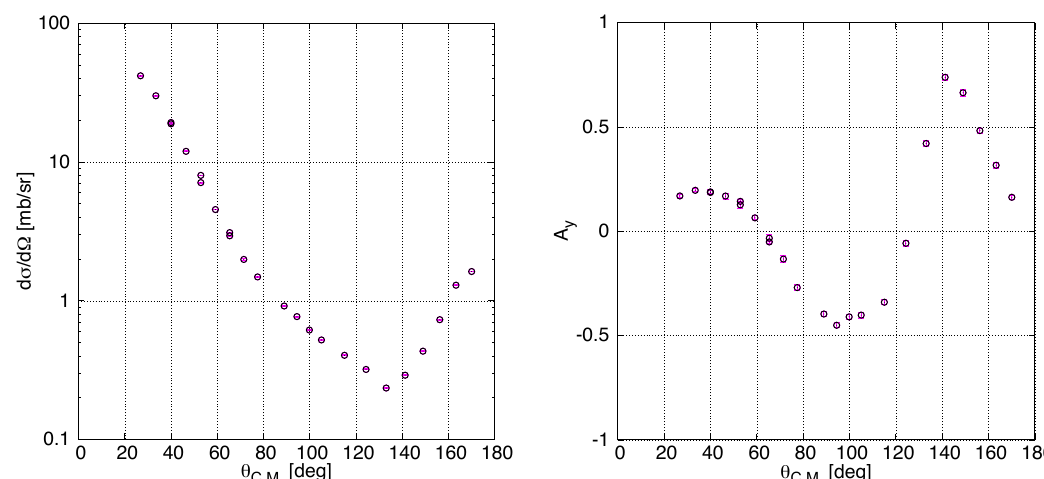
Figure 3: The cross section and the proton analyzing power A scattering at 65 MeV with respect to the angles in the center of mass